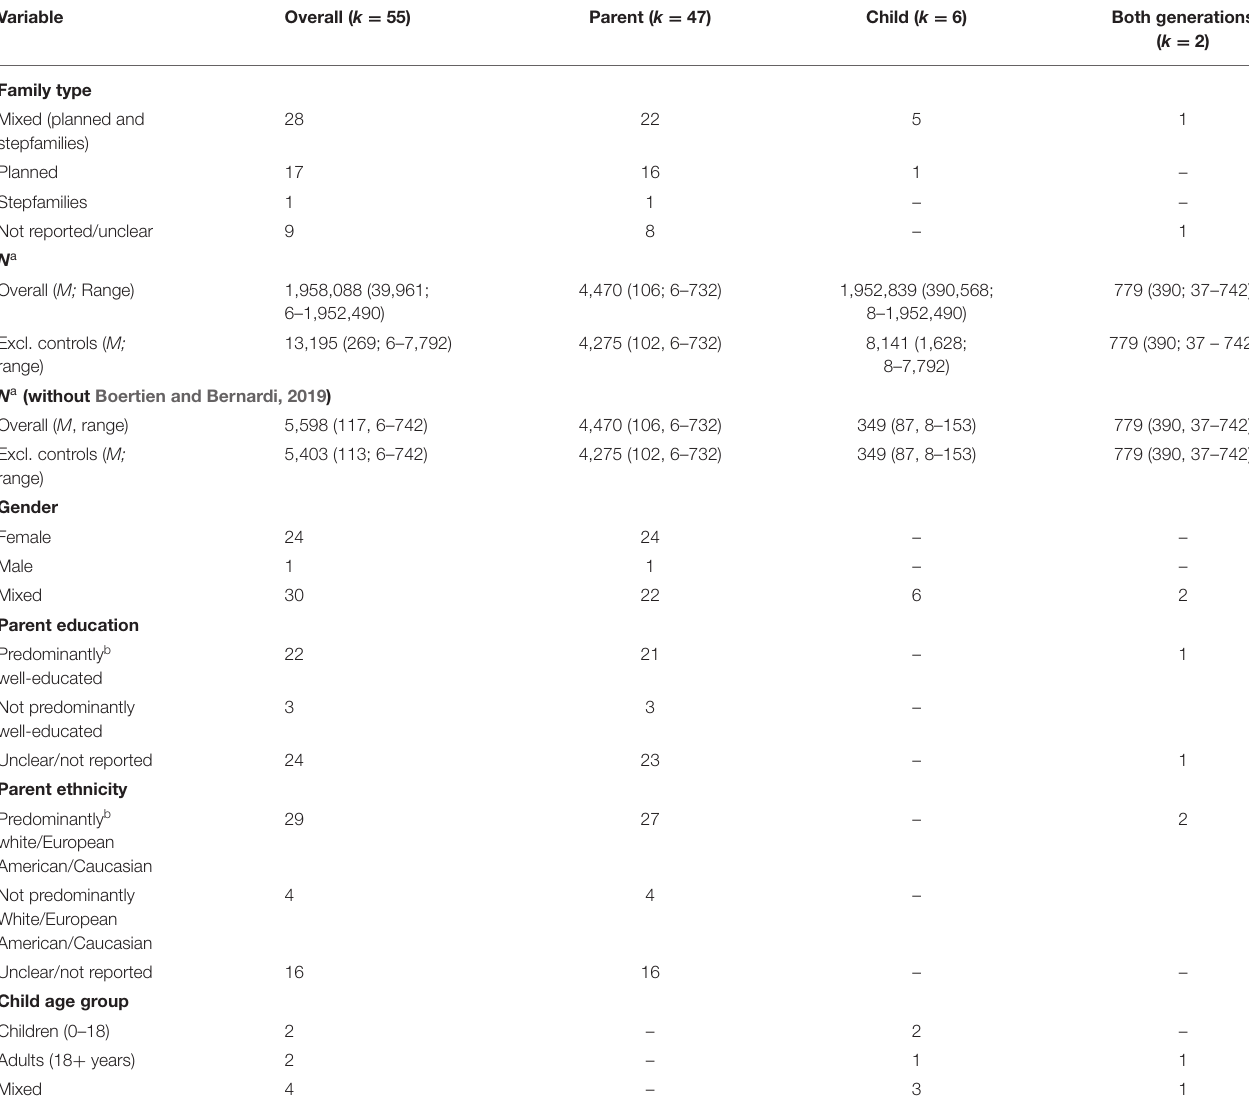
TABLE 2 | Study characteristics related to sociodemographics; overall and stratified by investigated generation.